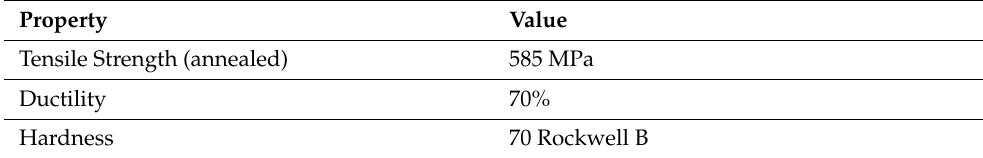
Table A2. Mechanical Properties of 304 Stainless Steel.